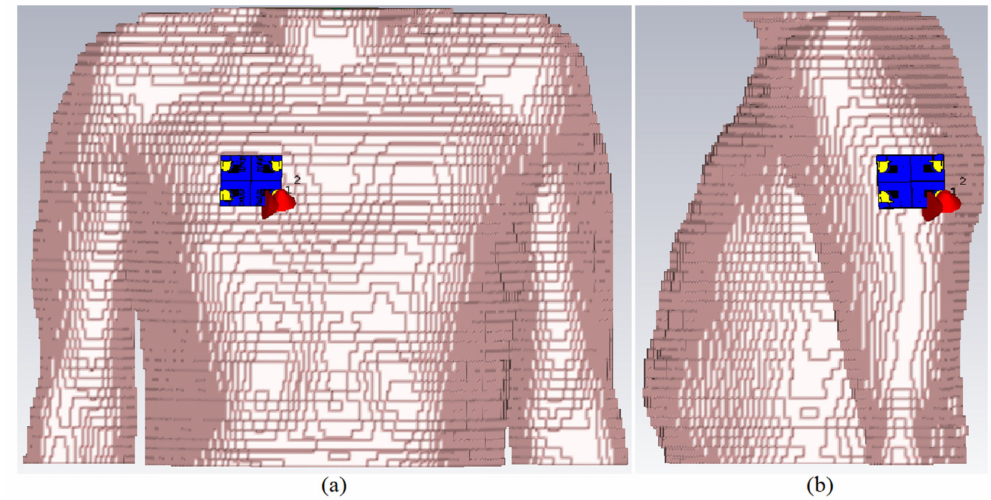
Figure 27. The proposed 8 ports MIMO antenna on the Gustav voxel model: ( a ) chest and ( b )